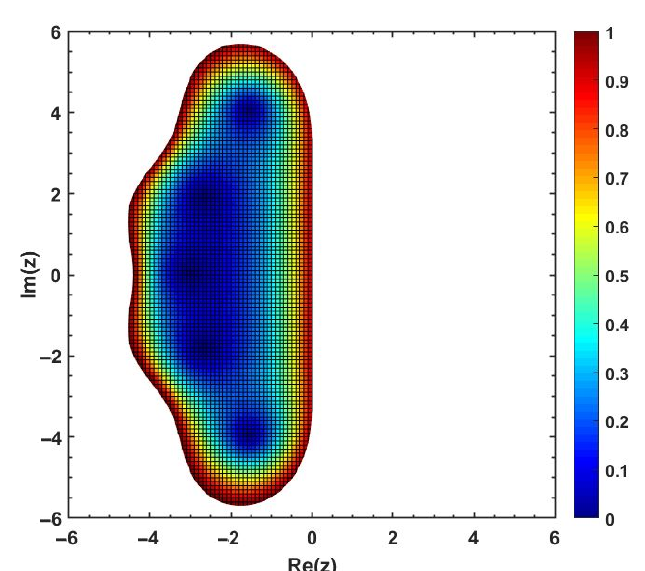
Figure 1. Stability region (shaded region) obtained from Equation (26) for the proposed optimal block